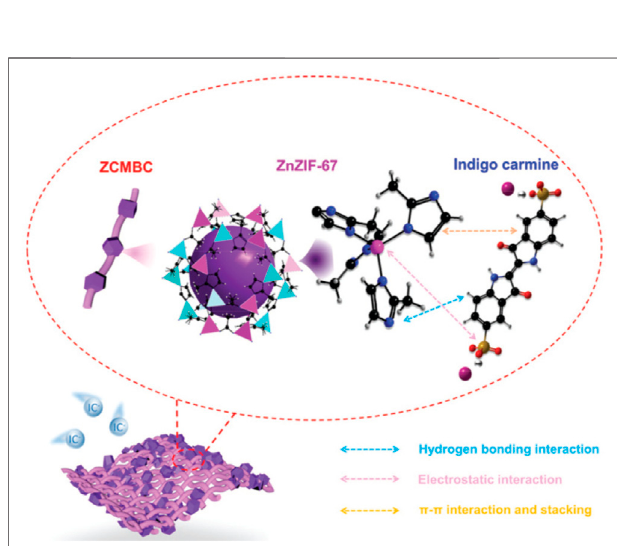
FIGURE 5 | Proposed schematic diagram for adsorption mechanism of IC − by ZCMBC composite fi lms. The atoms are colored as follows: carbon (black), sulfur (earthy yellow), oxygen (red), zinc (light blue), cobalt (pink), sodium (wine red), hydrogen (grey), and nitrogen (dark blue). The light purple sphere indicates the cavity of ZnZIF-67 (Mai et al.,